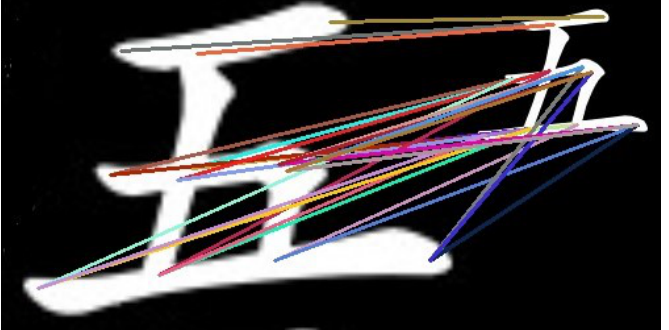
Figure 7. Feature point matching by the angle between each feature point and the character